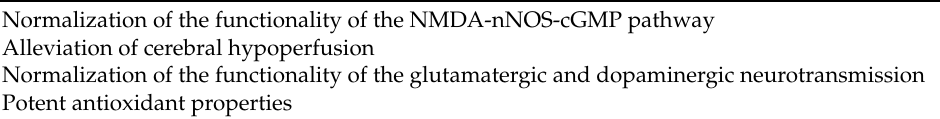
Summary of the potential mechanism(s) of action of sodium nitroprusside (SNP) in schizophrenia. Normalization of the functionality of the NMDA-nNOS-cGMP pathway Alleviation of cerebral hypoperfusion Potent antioxidant